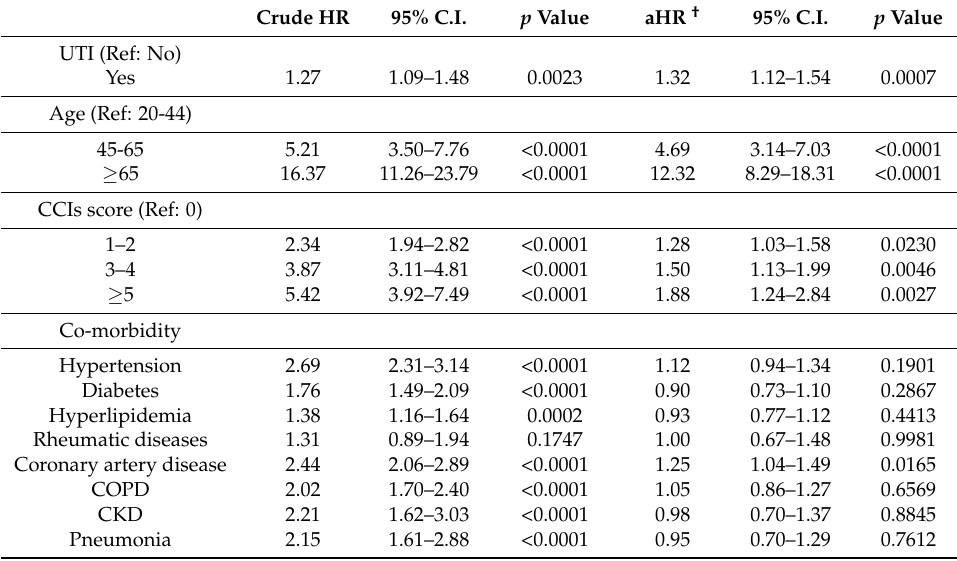
Table 3. Adjusted hazard ratio of all cancer in